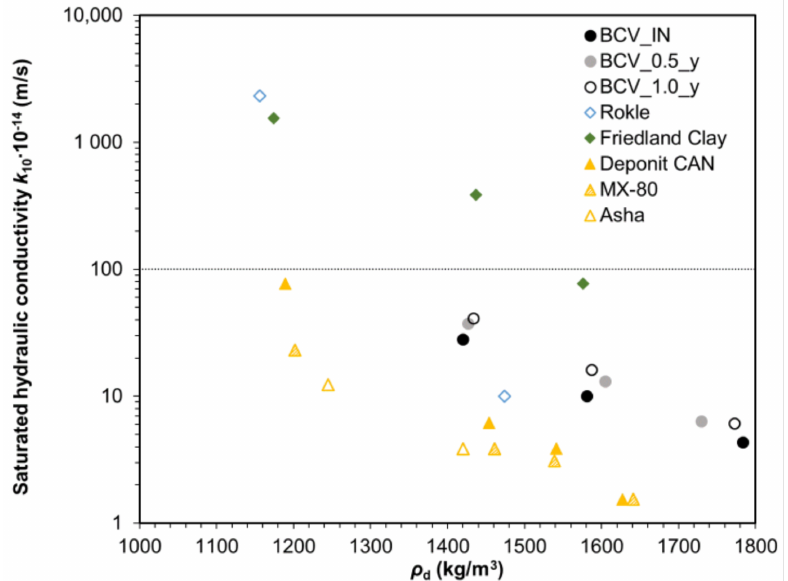
Figure 9. Saturated hydraulic conductivity of BCV compared to data for Friedland clay, Rokle, Deponit CAN, MX-80, and Asha